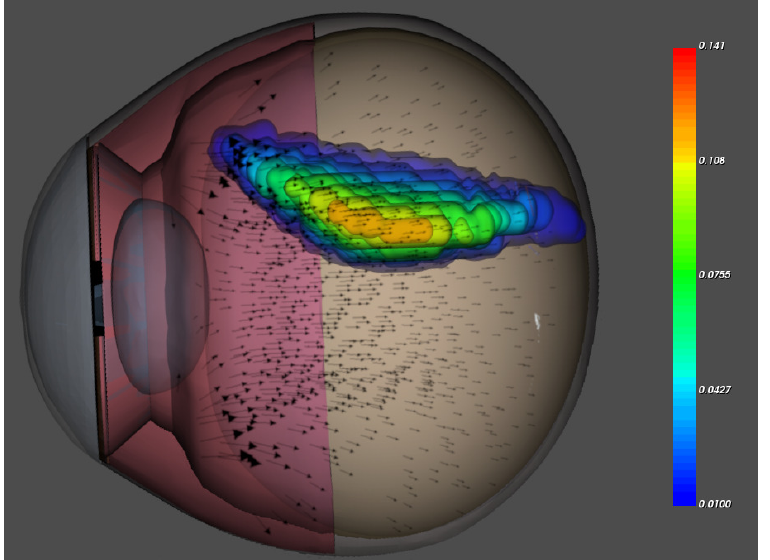
Figure 2. Our Virtual Eye with cornea, sclera, iris, lens, ciliary body, vitreous and retina; the drug concentration at a given time visualized with isosurfaces and the vitreous humor flow represented with